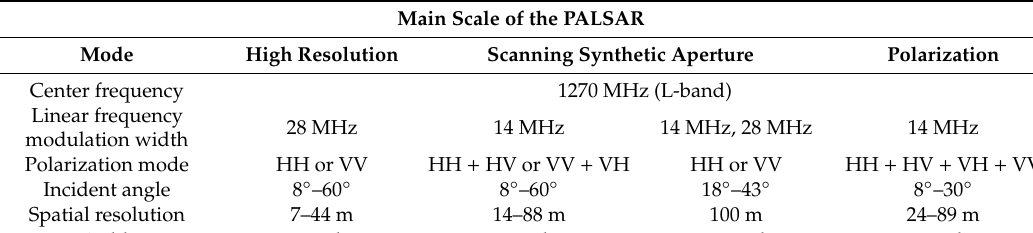
Table 1. Data specification sheet of the PALSAR and